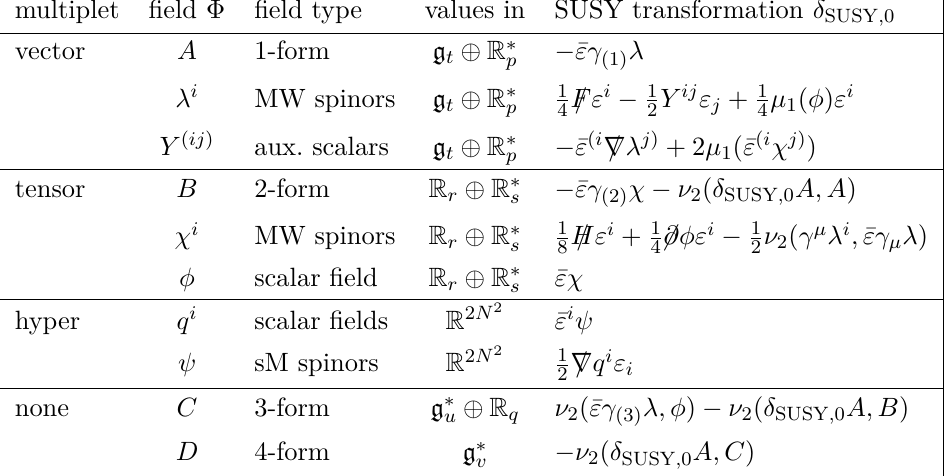
Table 1 . The field content with its behavior under Lorentz and supersymmetry transformation as well as its gauge labels. Our convention for the Feynman slash notation is found in appendix C and ∇ := d + [ A, − ] . The spinor chiralities are given by γ 7 (cid:15) = (cid:15) , γ 7 λ = λ , and γ 7 χ = − χ